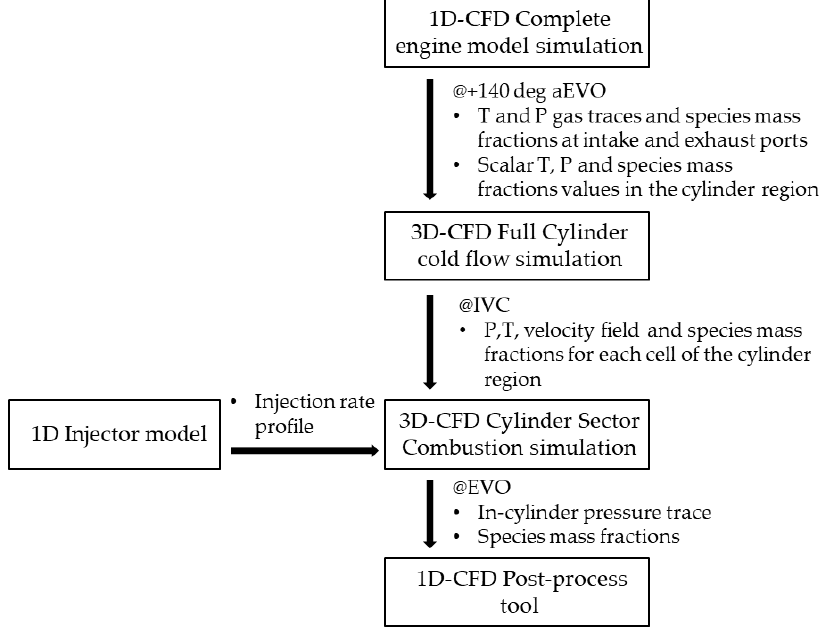
Figure 3. Block diagram schematizing the proposed methodology.